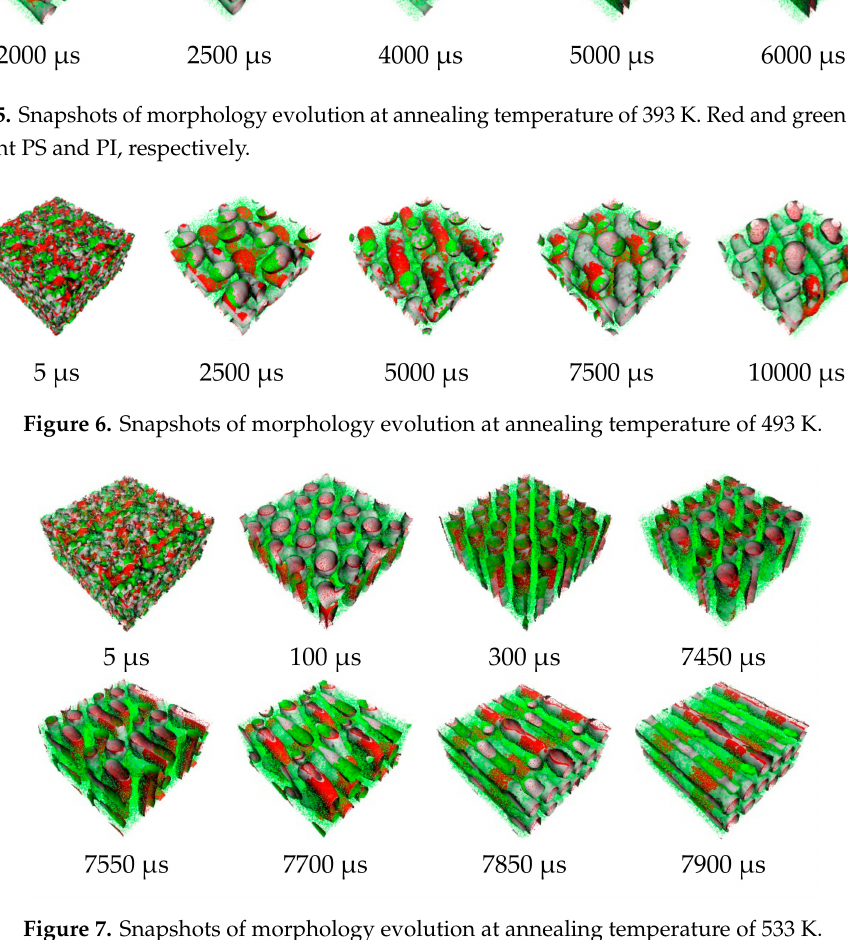
Figure 7. Snapshots of morphology evolution at annealing temperature of 533